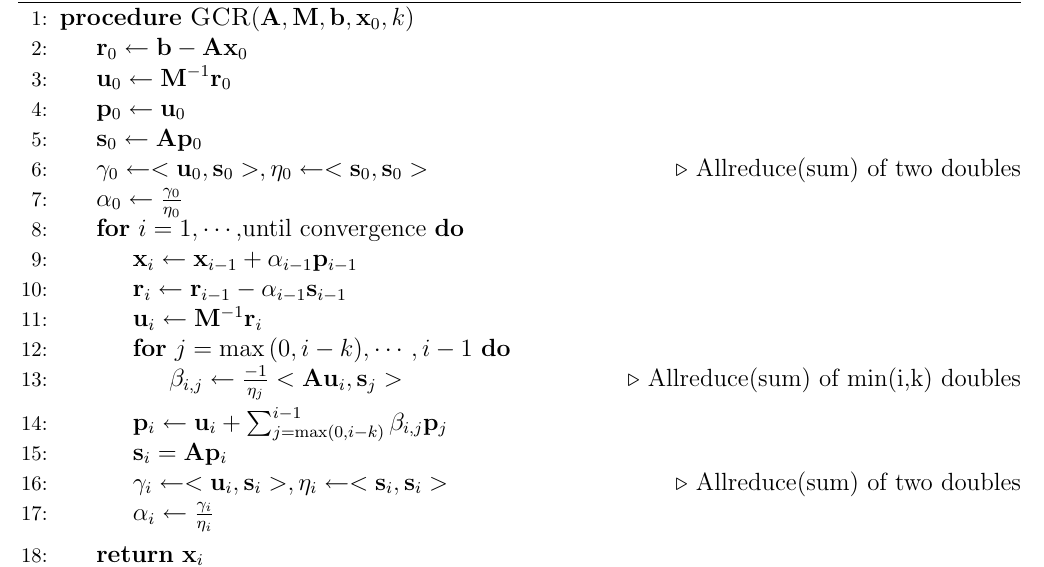
Algorithm 1 Preconditioned GCR returns the solution x i when convergence occurs where x 0 is the first guess solution and k is the number of iterations for